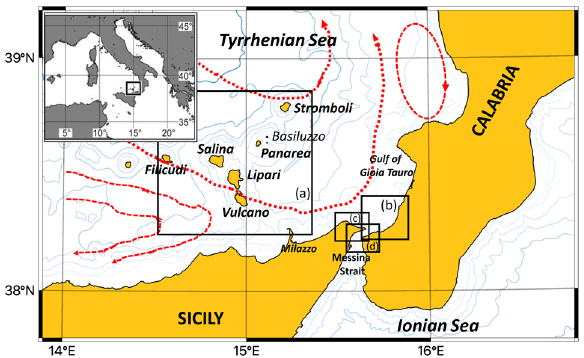
Figure 1. The eastern sector of the Southern Tyrrhenian Sea: boxes indicate the following sub-regions ( a ) Aeolian Island Archipelago; ( b ) Calabrian coast; ( c ) Sicilian coast; ( d ) Messina Strait. The main paths of surface circulation are depicted: the stream of AW flowing geostrophically and the anticyclonic recirculation cells. Map was generated with QGIS v. 3.22.6-Białowieża (https:// qgis. org/ it/ site/) under GNU General Public License. Coordinate Reference System: EPSG:4326 (WGS84).